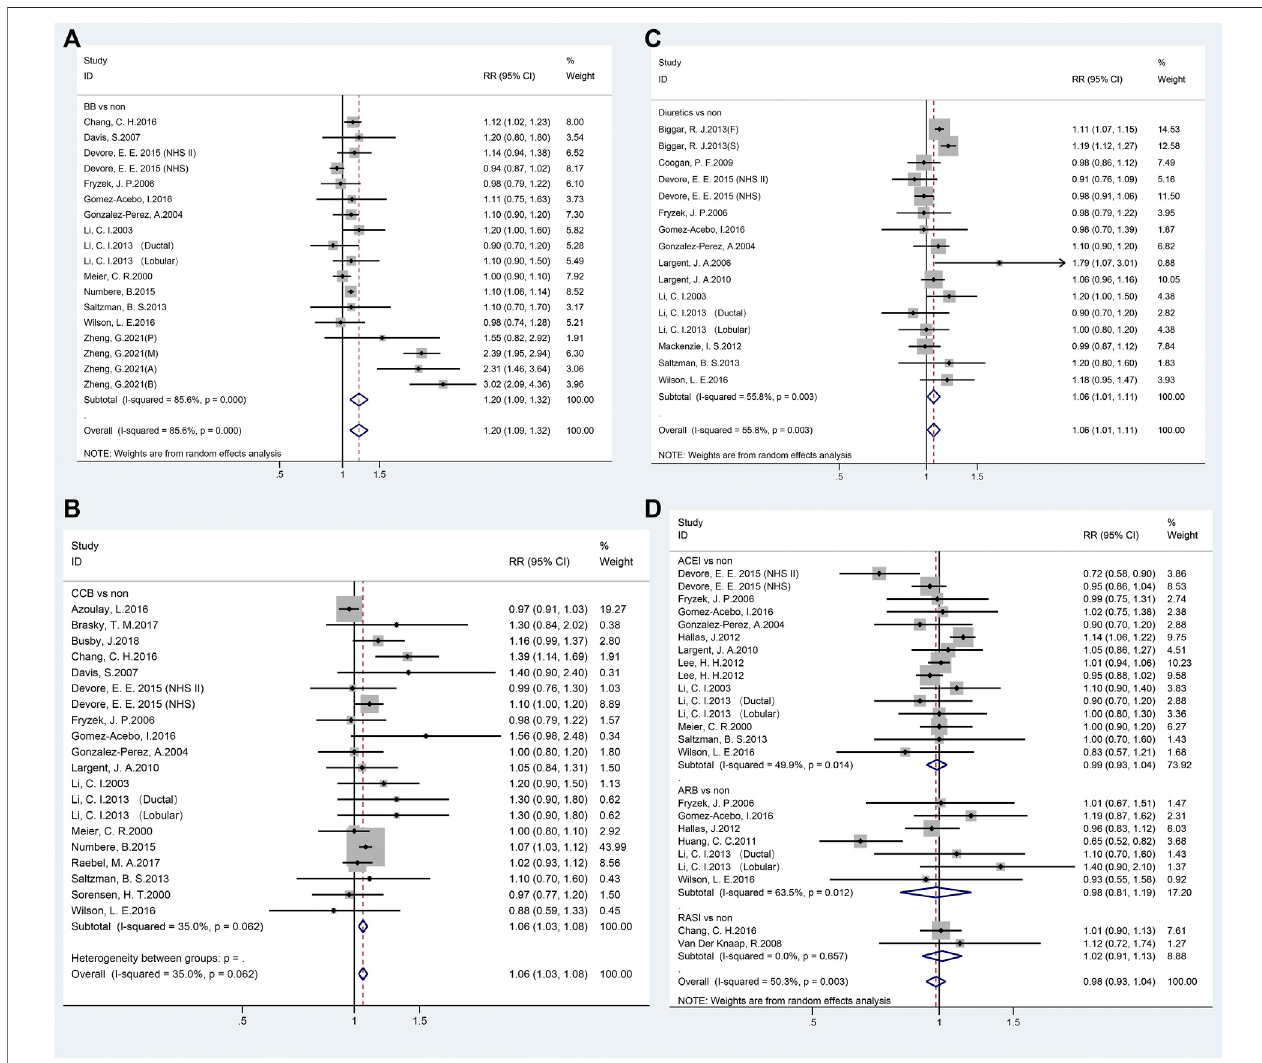
FIGURE2| Forest plotofstudies amongtheriskofbreast cancerwithantihypertensivemedicationsuse. Legends ( A beta-blockers; B : calcium-channelblockers; C : diuretics; D : renin-angiotensin system inhibitors).